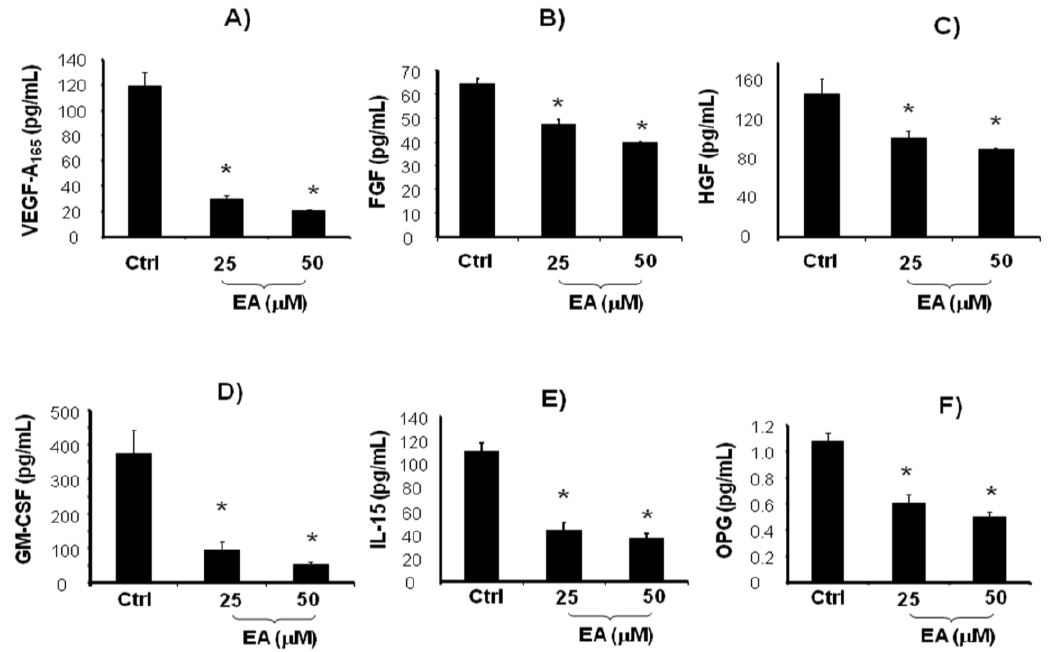
Figure 1. VEGF-A , FGF, HGF, GM-CSF, IL-15, and OPG ( A – F ) levels in LnCaP cells 165 untreated and treated for 48 h with EA at different concentrations (25 and 50 μM). Values represent the means ± SD of 4 experiments performed in triplicate. * Significance versus untreated control cells: p <